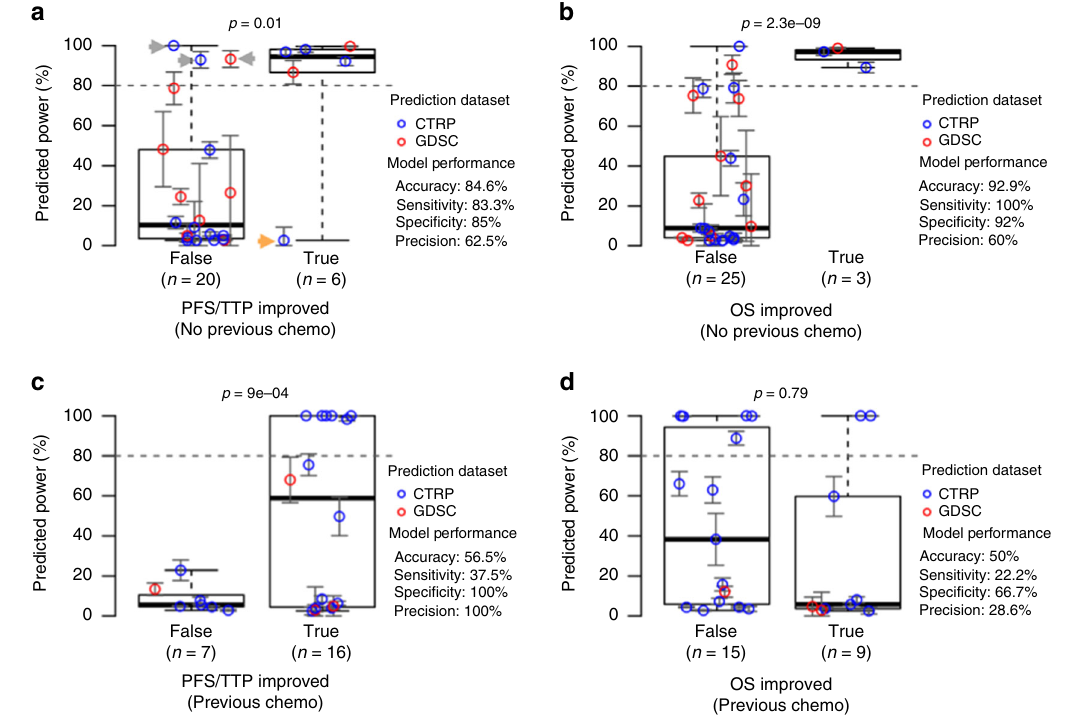
Fig. 4 Clinical trial validation results show accurate ef fi cacy predictions for trials in previously untreated patients but not for trials in previously treated patients. IDACombo was used to make ef fi cacy predictions for the control and experimental treatments of the clinical trials selected using the pipeline in Fig. 3. Hazard ratios were then calculated using these predictions, and study powers were calculated for each available comparison of a control therapy vs. an experimental therapy. These comparisons are separated based on whether or not the experimental arm statistically improved either PFS/ TTP (panels a and c ) or OS (panels b and d ) in the published trial results. Predicted powers for each comparison are plotted on the y -axes, and an 80% power threshold (dashed line) is used to classify whether or not a comparison is expected to yield a statistically signi fi cant improvement. Comparisons are colored according to the dataset used to make predictions for the compared treatments. Panels a and b show results for trials in which patients had received no previous drug treatments. Panels c and d show results for trials in patients who had received previous treatment. Error bars for each plotted clinical trial power represent mean estimated power ± standard error (bounded between 0% and 100% power). Gray and orange arrows in Panel a indicate misclassi fi ed trials that are discussed in the text. P values were calculated using one-tailed t -tests. Blue circles indicate predictions made using the CTRP dataset, and red circles indicate predictions made using the GDSC dataset. Boxplots are plotted so that the lower and upper whiskers indicate the extreme lower and upper values, respectively, the box boundaries indicate the fi rst and third quartiles, and the center line indicates the median. Source data are provided as a Source Data fi